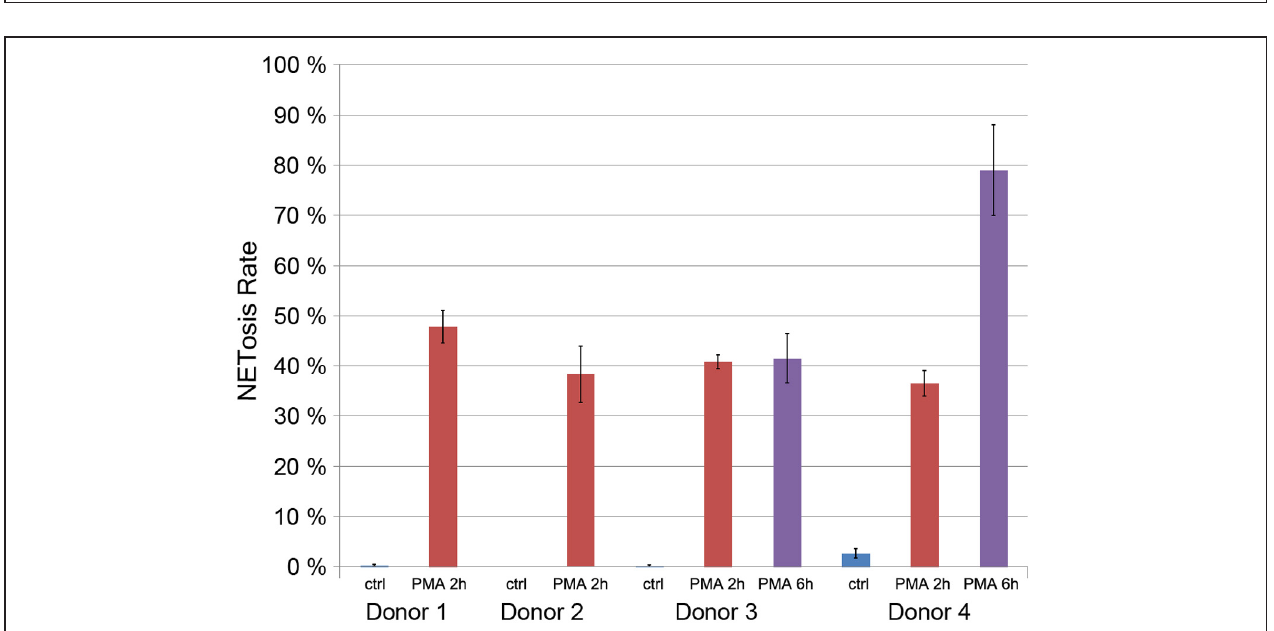
FIGURE 3 | Neutrophils stimulated with PMA for 130min and stained with Hoechst 33342 (panel 3A, boxed area panel 3D) and PL2-3 (panel 3B, boxed area panel 3E). The overlap is shown in panel 3C (blue, DNA; red, chromatin; boxed area in panel 3F ). Automatic segmentation of the